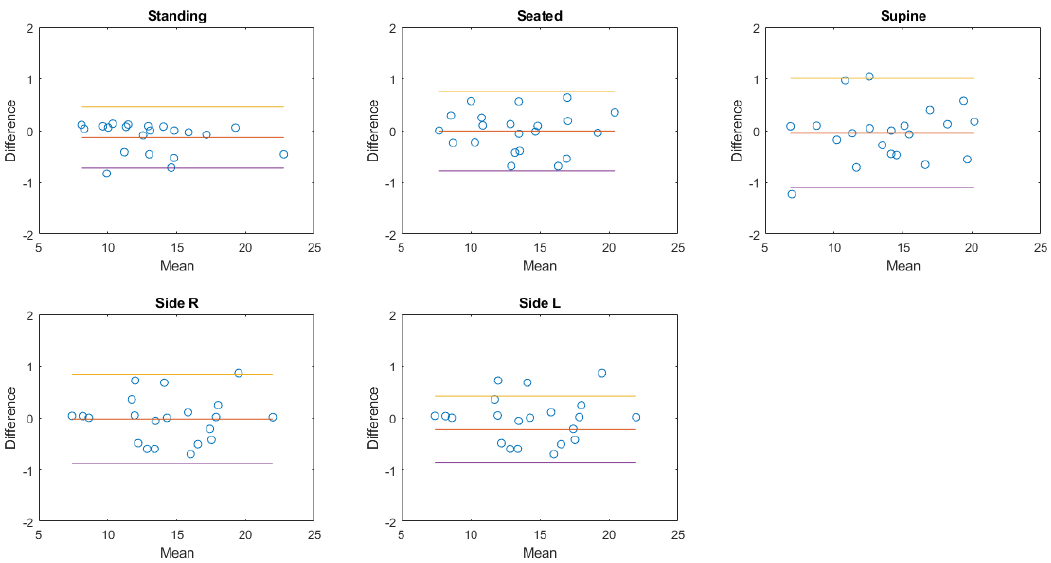
Figure 14. Bland–Altman plots of the aggregated results of respiratory rate at rest. Each dot represents the value obtained from a single subject. The yellow line represents the upper limit of agreement (mean error + 1.96 × standard deviation); the red line represents the mean error; the purple line represents the lower limit of agreement (mean error − 1.96 × standard deviation).